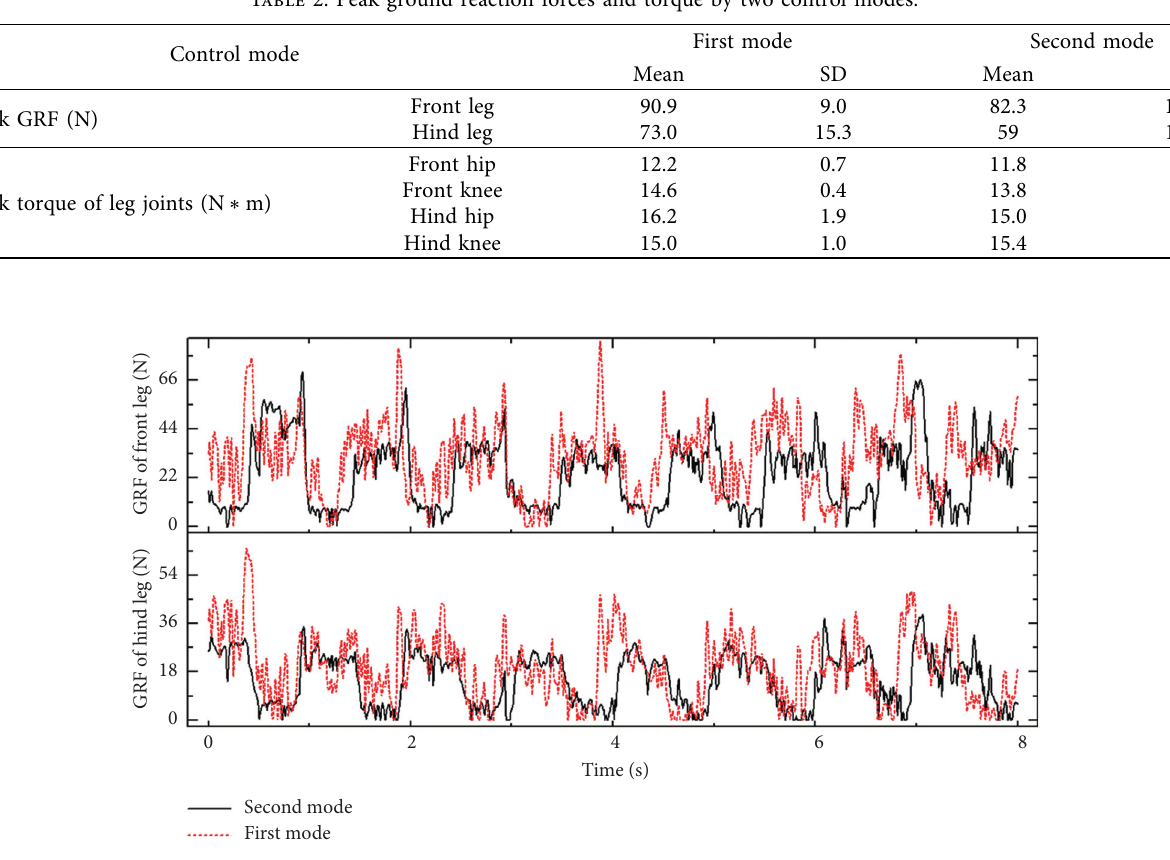
Figure 13: Ground reaction forces of the quadruped robot by two control